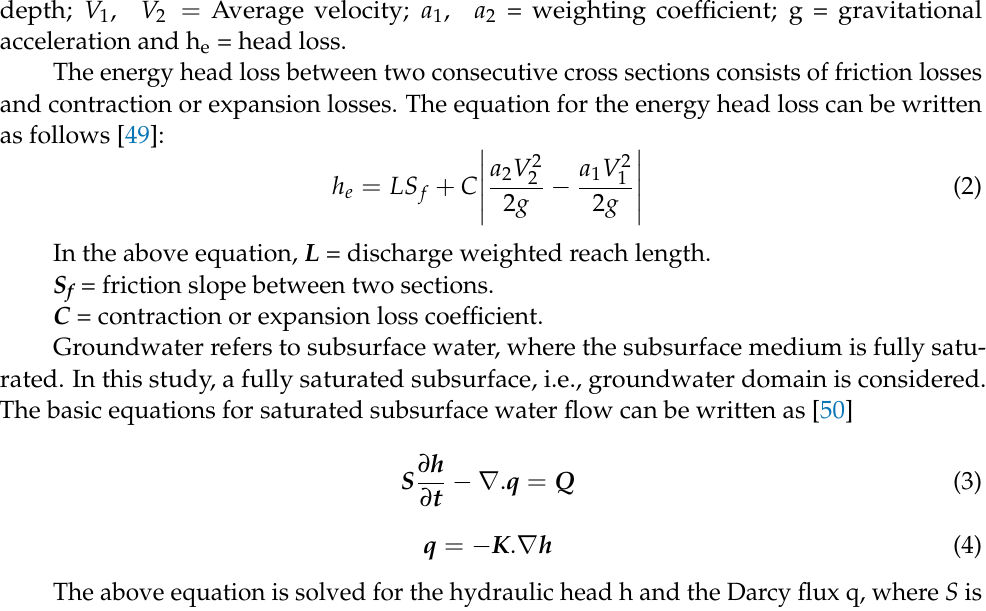
Figure 1. A visualization of the water surface profile with a gradient due to the undulation in streambed for a typical one-dimensional surface water model. Due to the change in elevation of the channel bed, a hydraulic gradient occurs, which is the key parameter to generate hyporheic exchange. In the above equation, Z 2 , Z 1 = bed elevation of the channel bed, Y 2 , Y 1 =